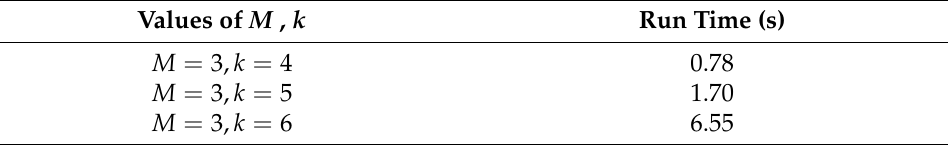
Table 3. Run times of Example